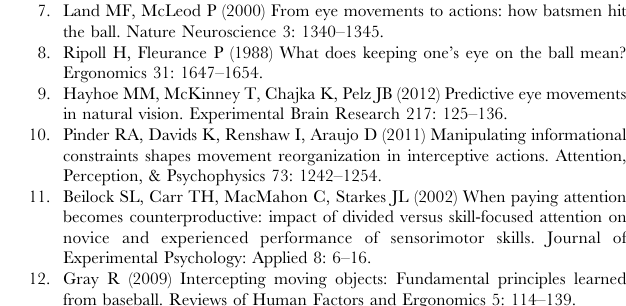
Figure 5. Saccadic eye movements. Horizontal lines represent the time course of each trial for the two elite (E1 & E2) and two club-level (C1 & C2) batters, showing (i) the presence and timing of saccadic eye-movements, and (ii) whether gaze coincided with the ball at the moment of bat-ball contact. NS indicates that no saccade took place in that trial.